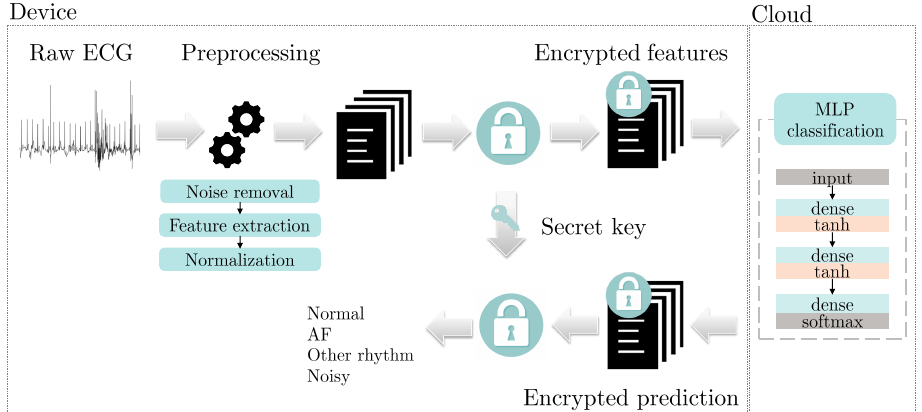
Figure 2. Workflow of the proposed privacy-preserving feature-based ECG classification